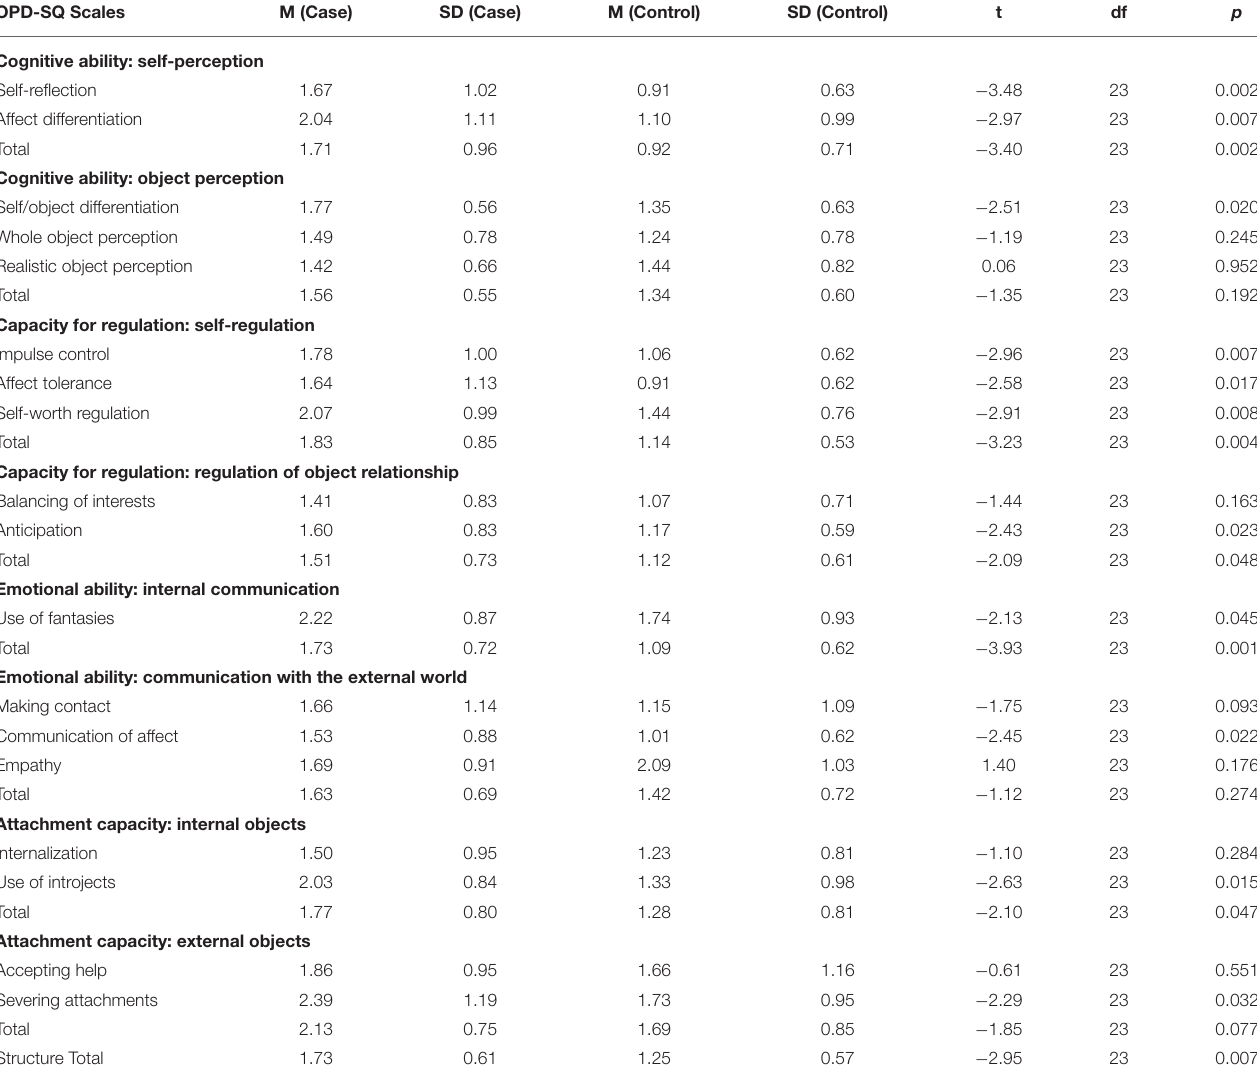
TABLE 3 | Comparison of OPD-SQ scores (paired-samples t -test). OPD-SQ